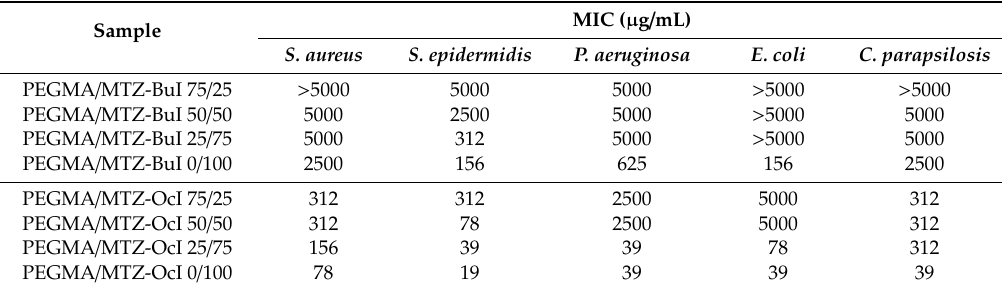
Table 3. Antimicrobial activities of the cationic copolymers P(PEGMA– co –MTZ-BuI) and P(PEGMA– co – MTZ-OcI). MIC, minimum inhibitory